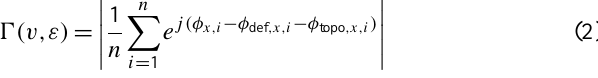
Fig. 2a (Track 25) and Fig. 2b (Track 297), respectively.